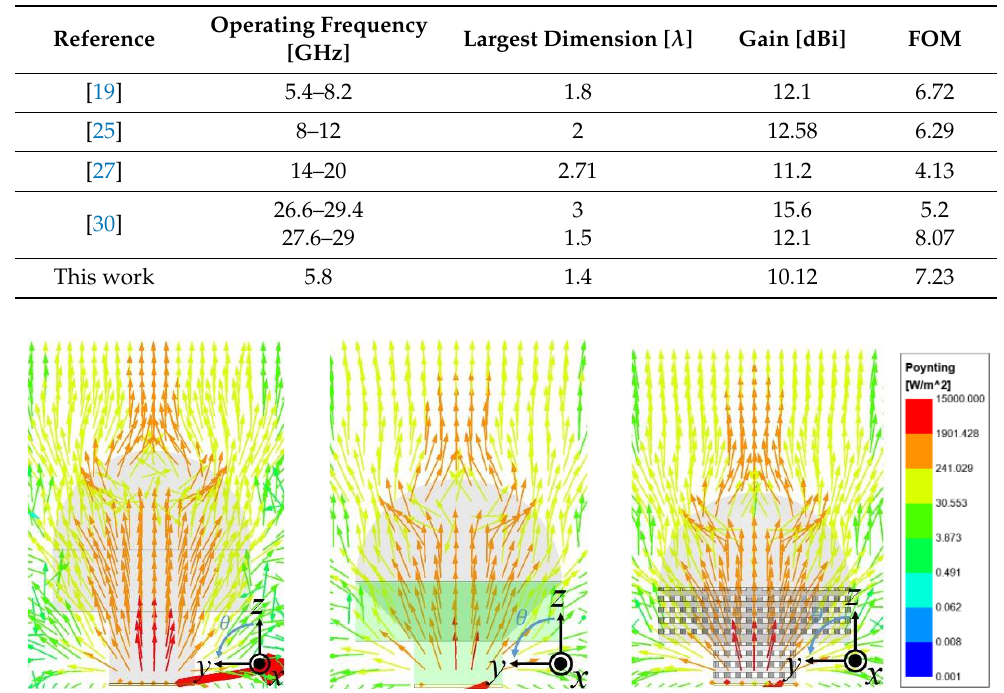
Figure 7. E-field distribution at 5.8 GHz. ( a ) Model 1. ( b ) Model 2. ( c ) Model 3. Table 1. Comparison table of the lens antenna. All the values are from the measurement. The wavelength for the dimension is calculated at the center frequency.